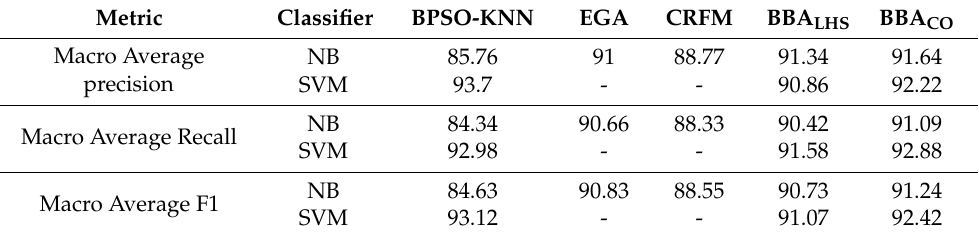
Table 22. Classification results of BBA R , BBA LHS , and BBA CO on Al-Jazeera news dataset compared with state-of-the-art